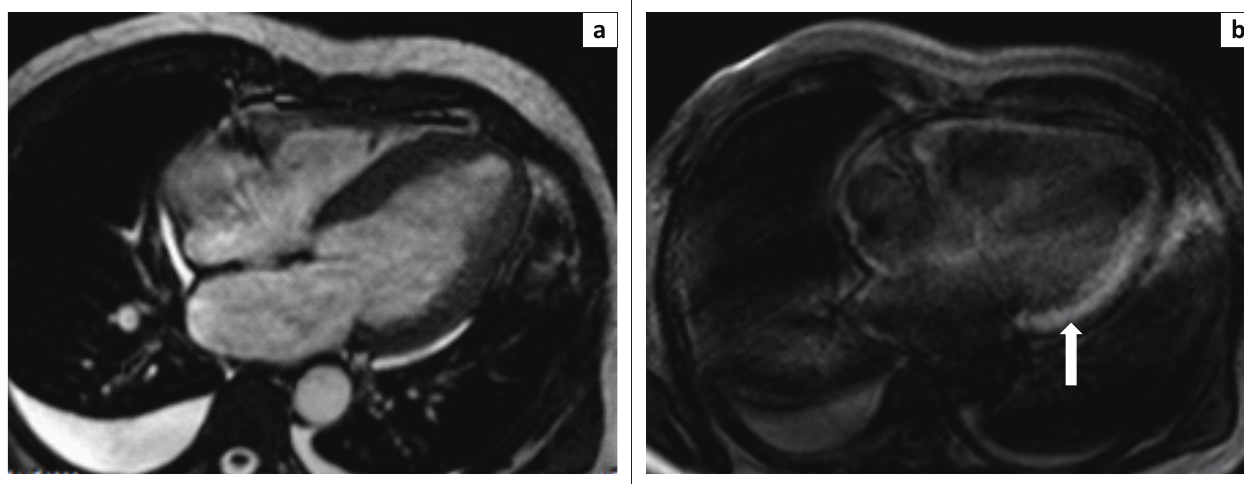
FIGURE 7: Amyloidosis. Four-chamber end-diastole cine b-SSFP image (left) demonstrates a thickened septum and LV lateral wall with small pericardial and pleural effusions. The four-chamber late gadolinium image (right) shows diffuse subendocardial enhancement (arrow) in a non-coronary artery distribution, with enhancement of the RV free wall and interatrial septum.